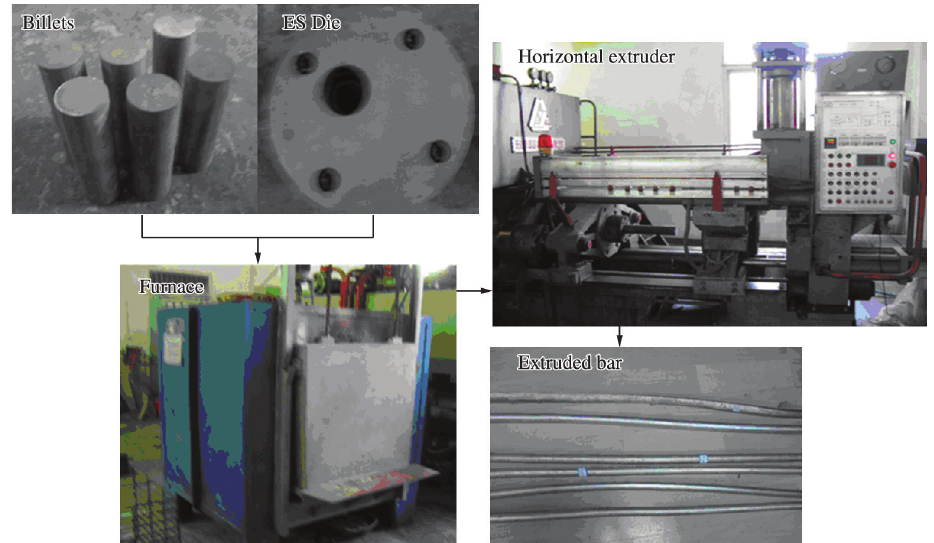
Figure 3. Schematic diagrams of forming steps during ES